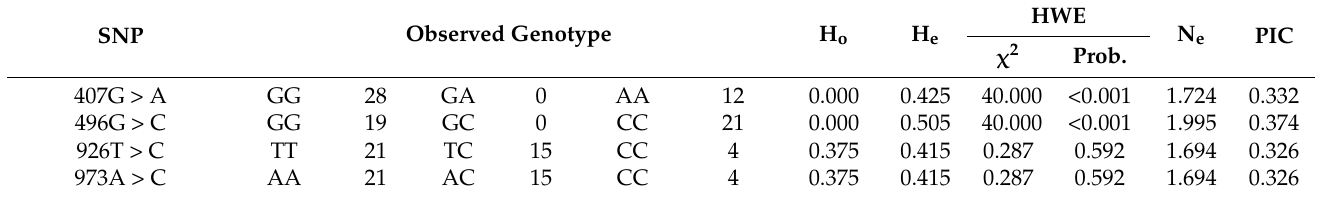
Table 1. Genotypic distribution and genetic diversity in four SNPs located on the PRLR.